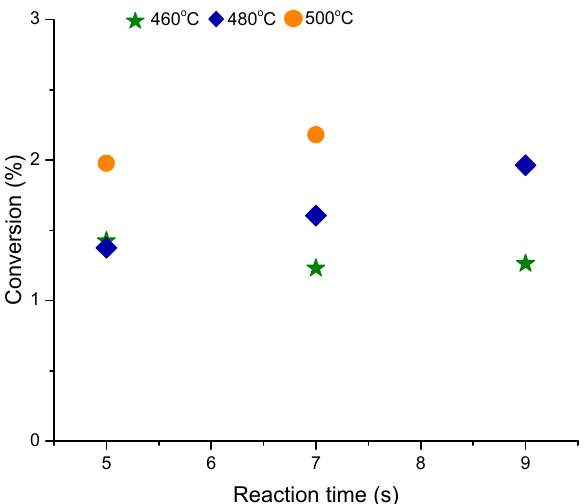
Figure 6. Average conversion with 95% confidence of ± 0.02 (from riser simulator reactor) at the same conditions over ZSM-5 with “hard coke” at 460–500 °C and 5–9 s. Table 2. Comparison of experimental results from riser simulator recorded with and without “hard coke” at the same conditions.